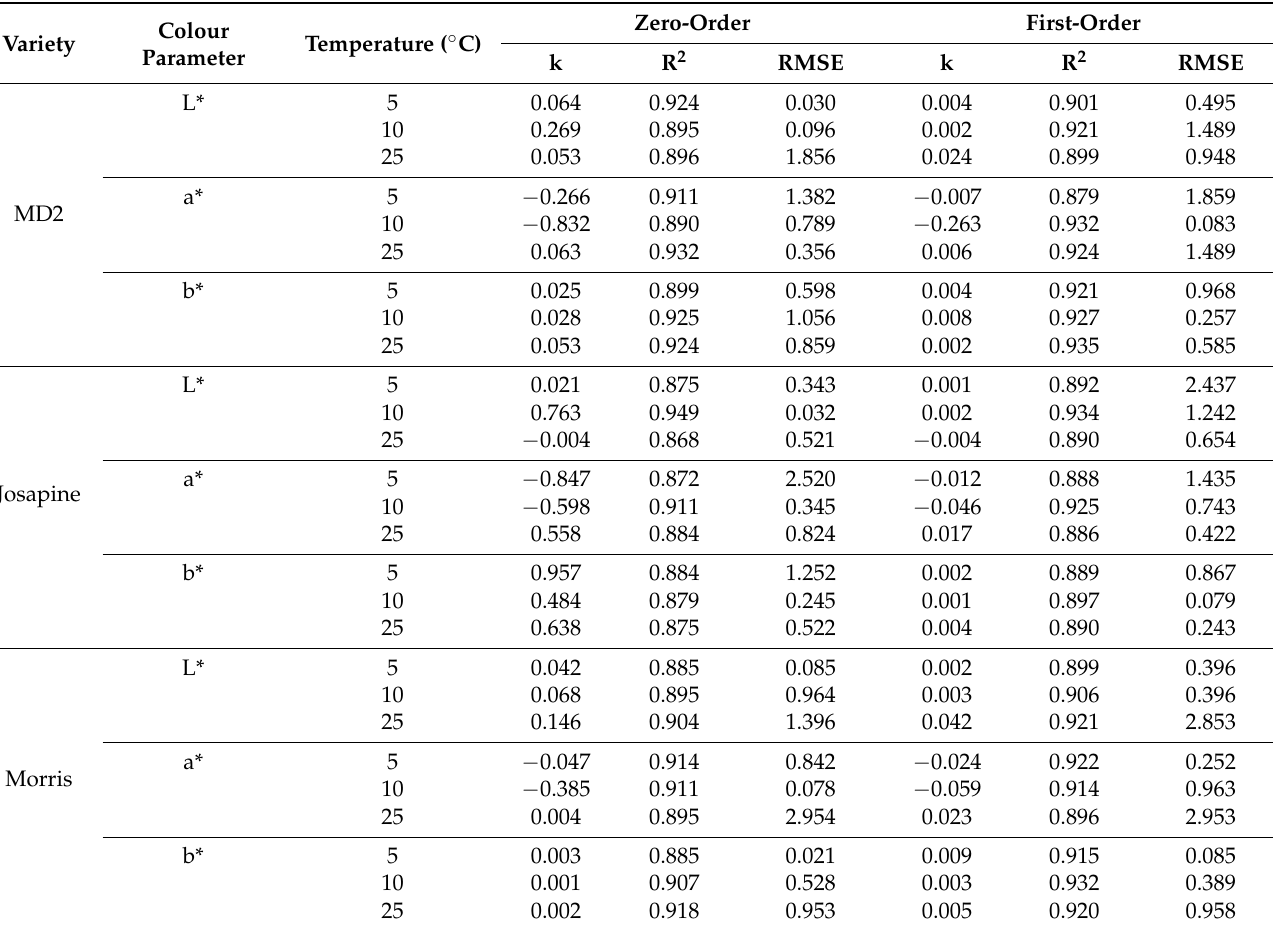
Table 4. Reaction order estimation for colour parameters of different pineapple varieties during